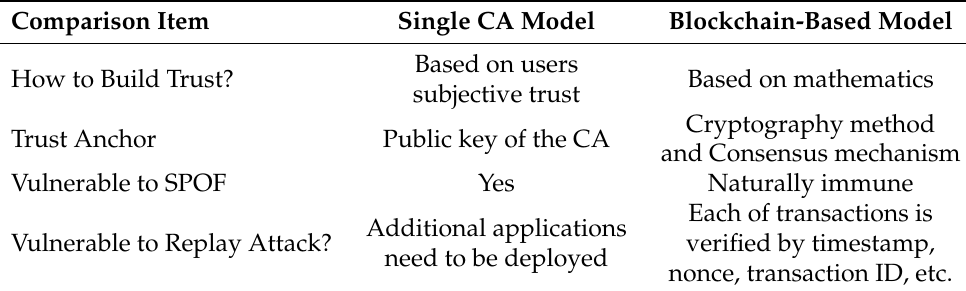
Table 1. Comparison of blockchain-based model and